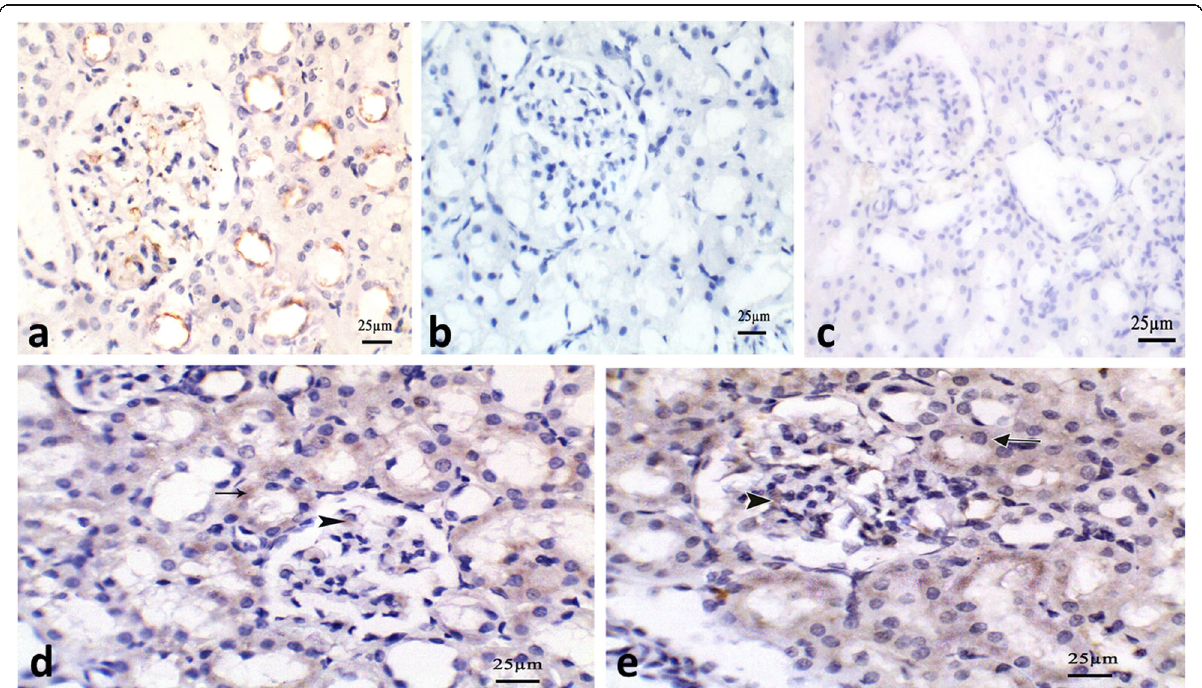
Fig. 6 Immunohistochemical staining of VEGF of renal cortex sections at magnification × 400, bar 25 μ m. a Control group shows positive reaction for VEGF expression in the tubules and glomeruli. b Diabetic nephropathy (DN) group shows negative reaction for VEGF expression in the tubules and glomeruli. c Fibroblast group shows negative reaction for VEGF expression in the tubules and glomeruli. d AD-MSCs group and e culture medium group show positive reaction for VEGF expression in the tubules (arrow) and glomeruli (arrow head)